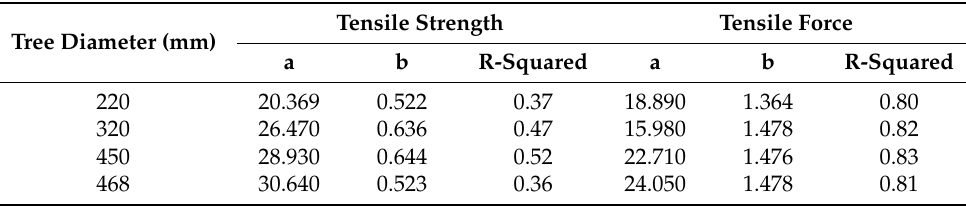
Table 5. The power-law functions coefficients for tensile strength and tensile for with co-efficient of correlation.